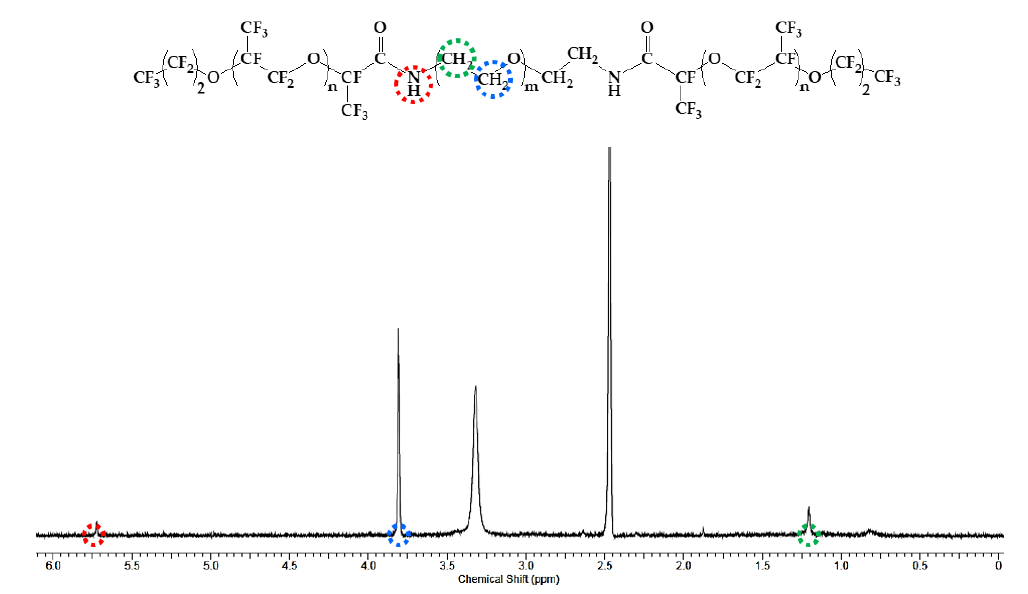
Figure 3. 1 H-NMR spectrum of synthesized PFPE–PEG–PFPE surfactant for structural analysis.